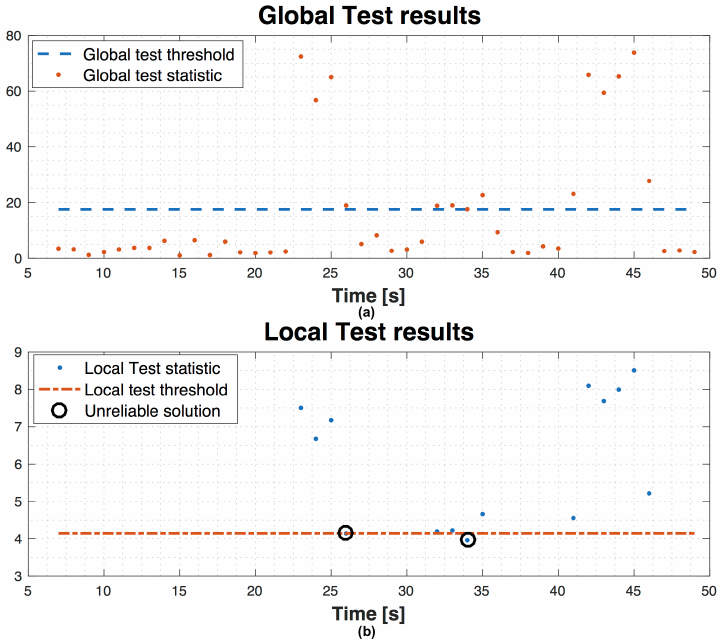
Figure 13. Example of global ( a ) and local ( b ) test on scenario 1 with two unreliable solutions.